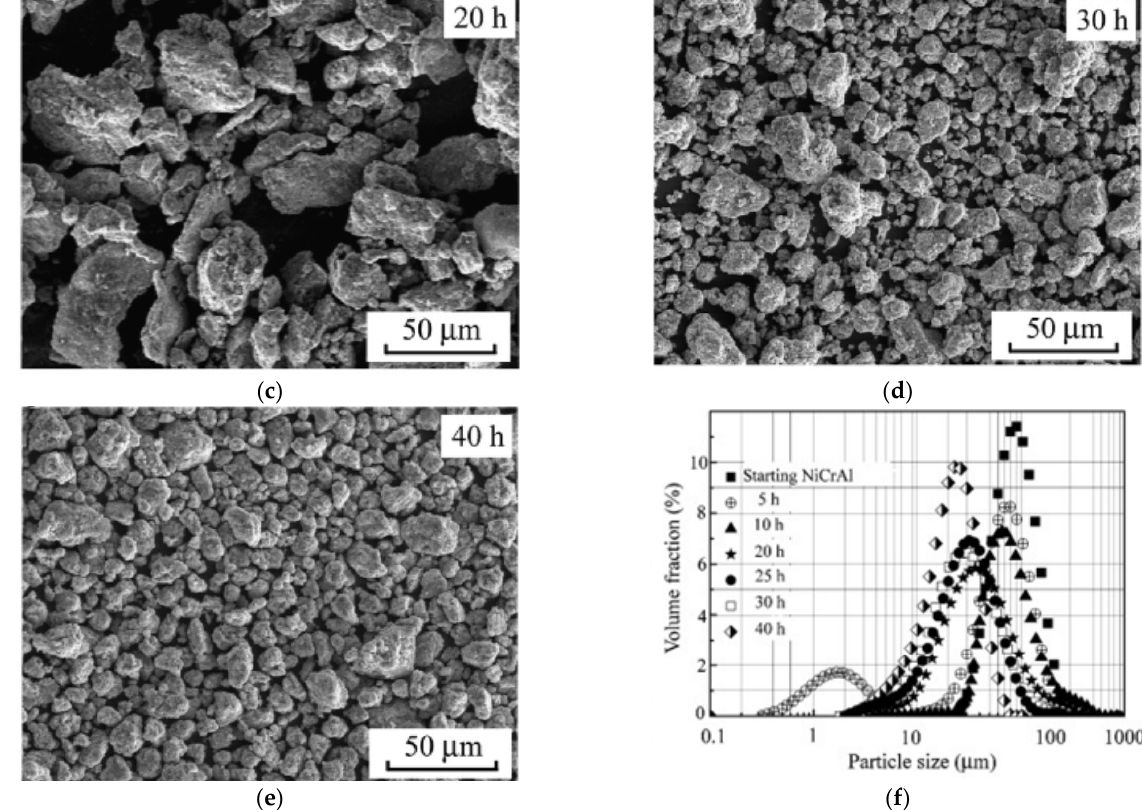
Figure 9. Morphology and particle size distributions of the powders ball milled at different durations: 5 h ( a ), 10 h ( b ), 20 h ( c ), 30 h ( d ), 40 h ( e ), the particle size distributions ( f ). Reprinted with permission from [125]. Copyright 2012 Elsevier.